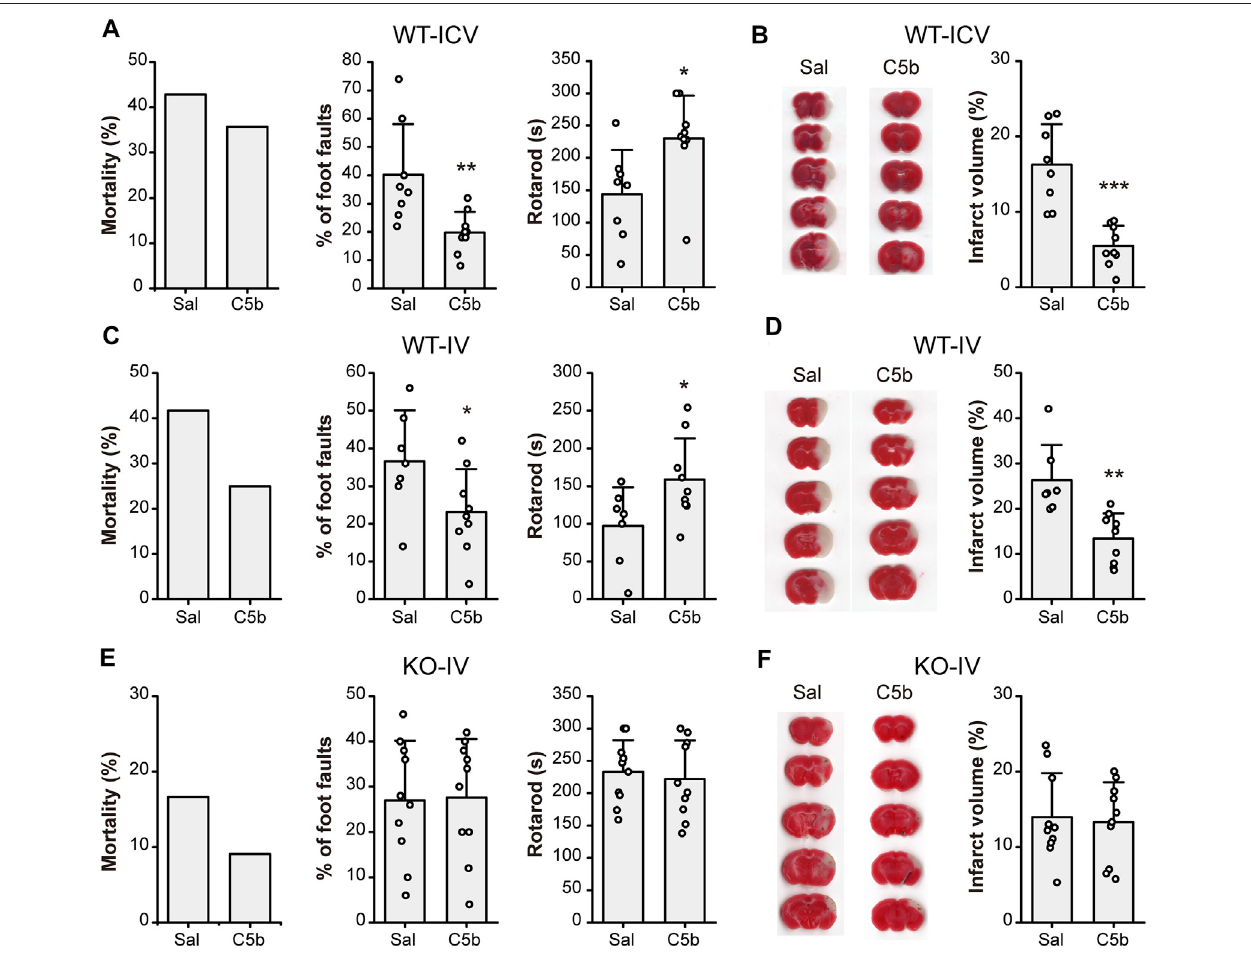
FIGURE4| C5b attenuated neurological impairmentand alleviatedinfarct volumeinmouse MCAOmodel ofischemic stroke. (A) Mortality rate( left ) and behavioral tests for motor ability ( middle , grid-walking test; right , rotarod test) of WT mice with intracerebroventricular (ICV) saline or C5b (1 μ L of 10 mM) treatment and subject to MCAO. n = 14 for each group. (B) TTC-staining of brain slices ( left ) and summary data of the infarct volume ( right ) of mice with ICV saline or C5b treatment. White areas standforinjuredbrainareawhilered representsuninjured areas. n =8or9foreach group. (C) Mortalityrate( left )and behavioral testsformotorability( middle ,grid- walkingtest; right ,rotarodtest)ofWTmicewithintravenous(IV)salineorC5b(5 mg/kg)treatmentandsubjecttoMCAO. n =12foreachgroup. (D) TTC-stainingofbrain slices ( left ) and summary dataoftheinfarctvolume ( right ) ofmice withIV saline orC5b treatment. n =8or 9foreach group. (E) Mortality rate( left ) and behavioral tests for motor ability ( middle , grid-walking test; right , rotarod test) of Asic1a KO mice with intravenous treatment and MCAO as in (C) . n = 11 for each group. (F) TTC-staining of brain slices ( left ) and summary data of the infarct volume ( right ) of KO mice with IV saline or C5b treatment. n = 10 for each group. All data are mean ± SEM. Statistical signi fi cance was determined with Student ’ s t test. * p < 0.05, ** p < 0.01, *** p <